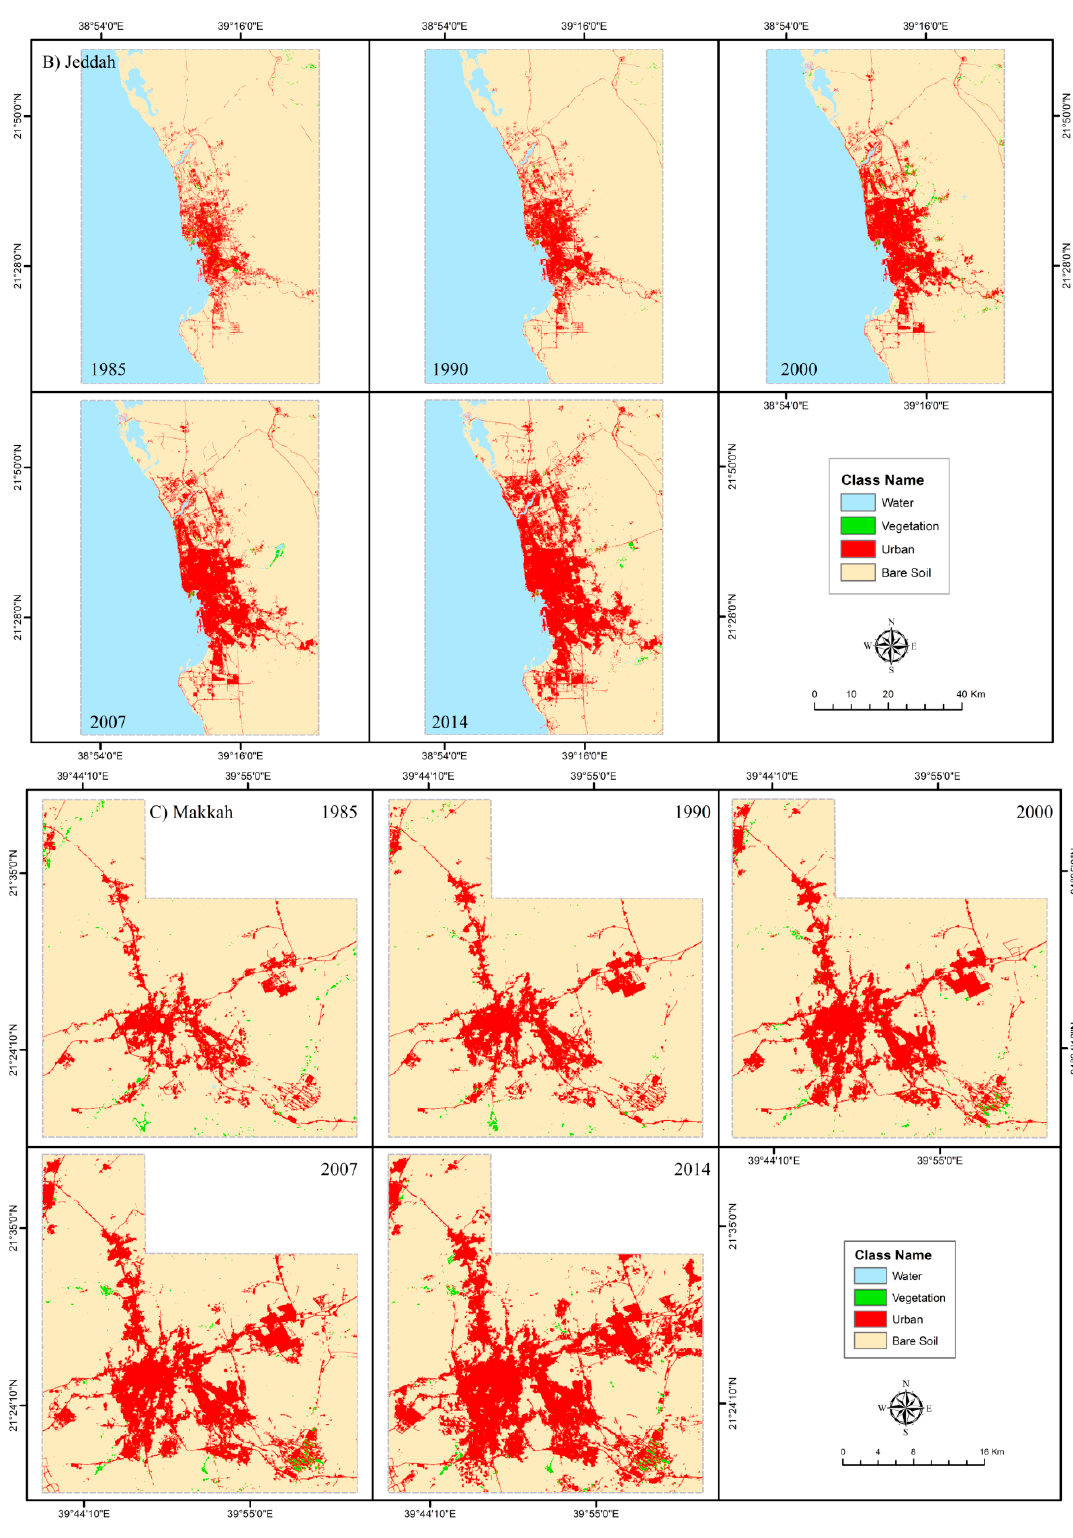
Figure 4. Spatial distribution of LULC changes between 1985 and 2014 in three cities: ( A ) Riyadh; ( B ) Jeddah; ( C ) Makkah.